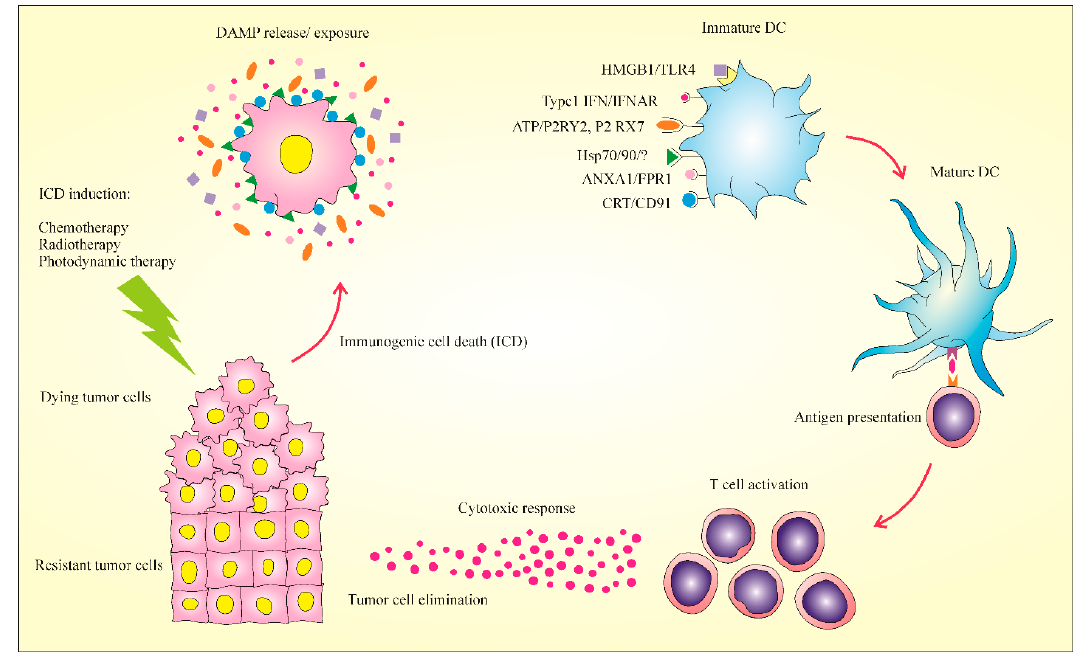
Figure 2. Major hallmarks of immunogenic cell death: The use of ICD inducers alone or in combination with other anticancer therapies stimulates the exposure or release of DAMP molecules. These DAMP molecules released from dying tumor cells stimulate the DCs’ recruitment into the tumor and activate T cells. Abbreviations: ICD; Immunogenic cell death, DAMP; danger-associated molecular patterns.